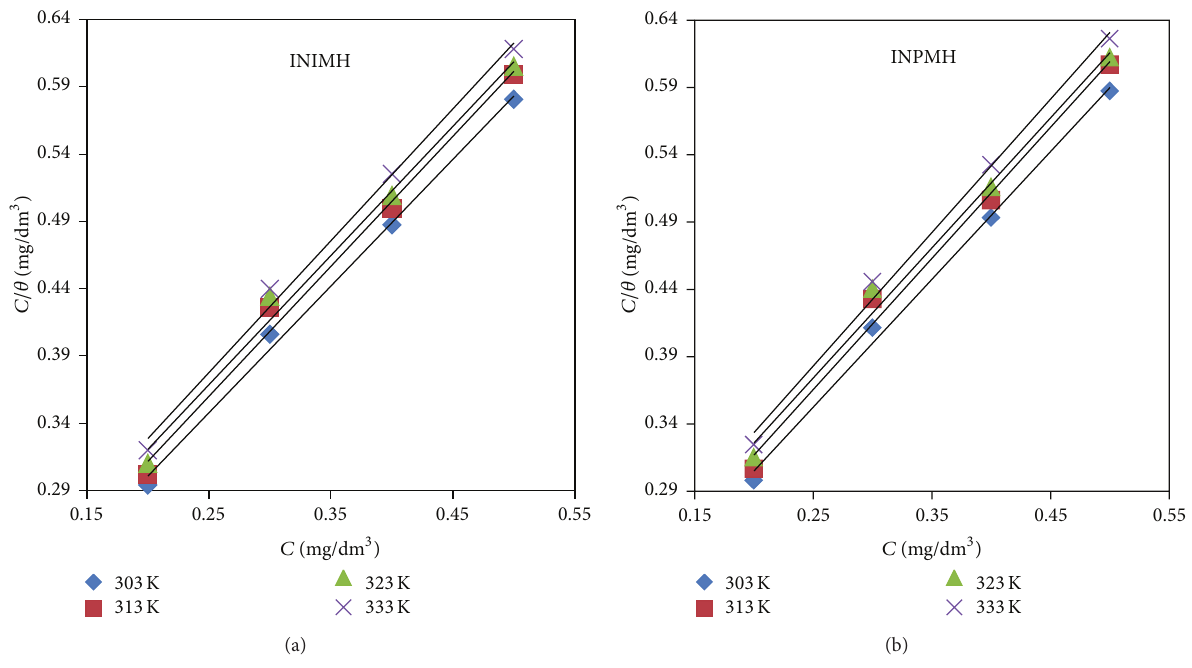
Figure 4: Langmuir’s adsorption isotherm plots for the adsorption of INIMH and INPMH in 0.5 M HCl on the MS surface at different temperatures.